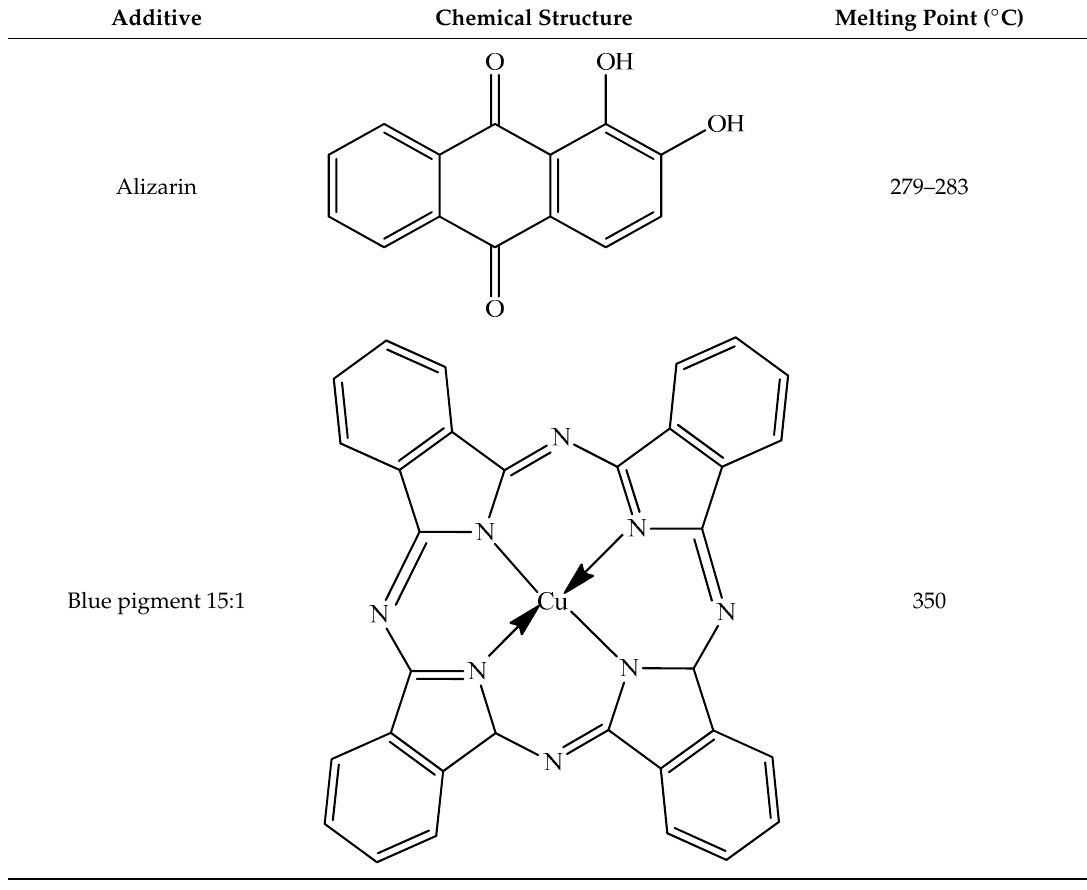
Table 1. Chemical structures and melting points of the colorants used in this study [43,44] Additive